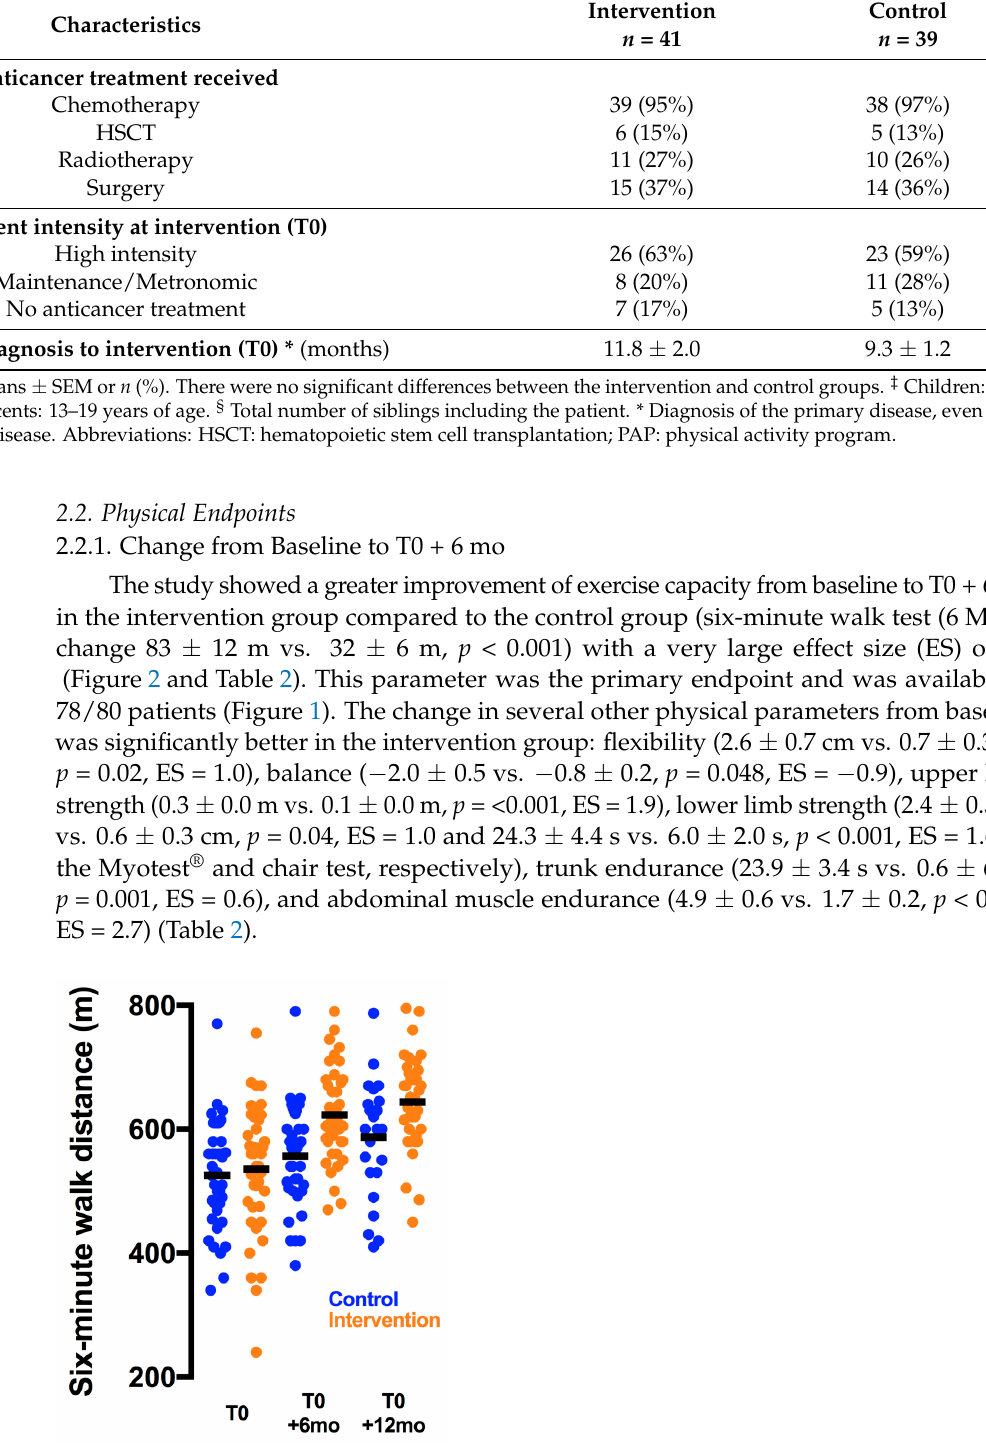
Figure 2. Evolution of the six-minute walk distance. Individual data points are shown; the horizontal lines indicate mean values. Table 2. Physical endpoints at six months.